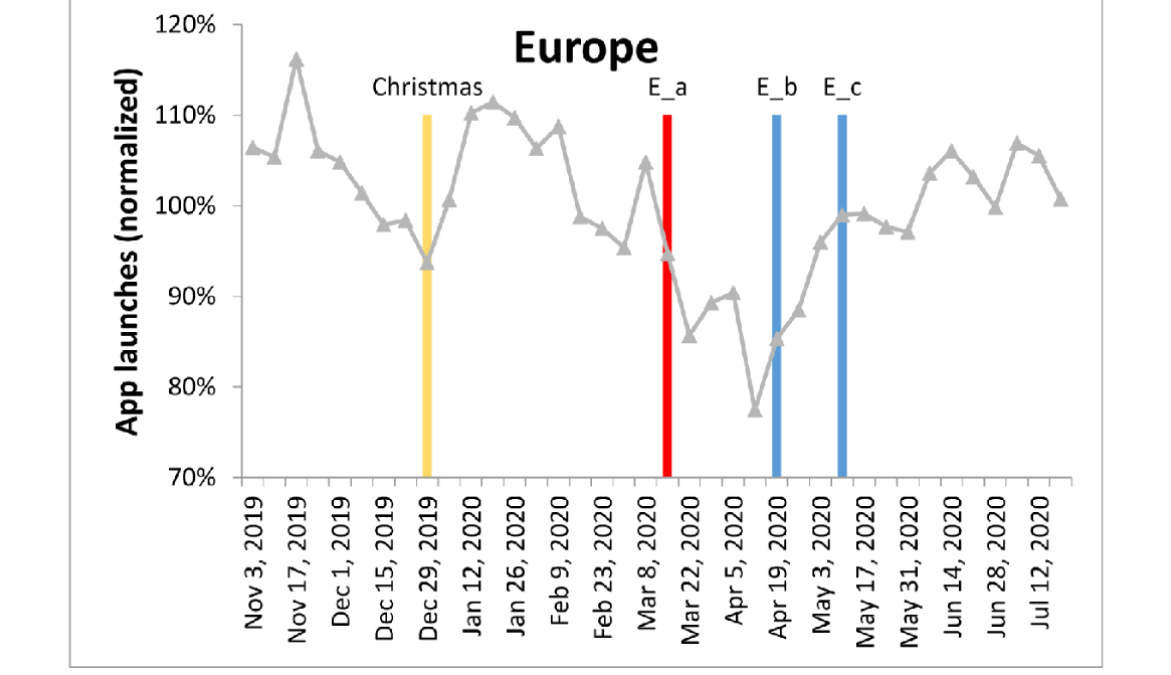
Figure 6. App launches in Europe, color-coded as in Figure 3. E_a: All shops and venues closed nationwide in Italy. E_b: Economy reopened in Germany. E_c: Lockdown restrictions started to be eased in several countries such as Spain, Italy, Denmark, and